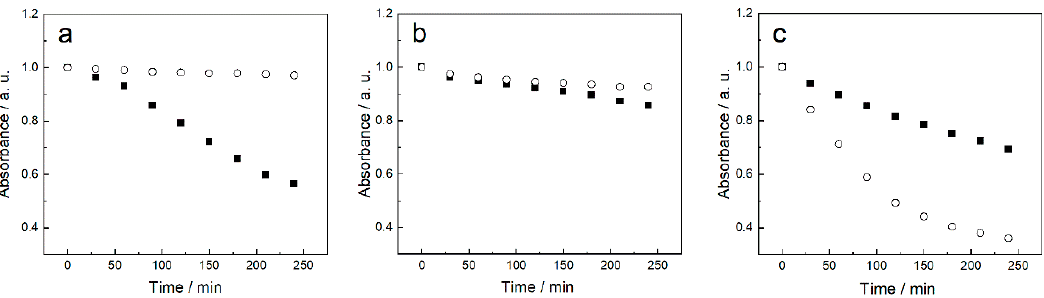
Figure 3. Comparison of time variation of the absorbance at specific wavelengths, referred to its t = 0 value, of quercetin (5 × 10 − 5 M) aqueous solutions in the absence (filled squares) and presence (open circles) of SB3-14 surfactant micelles (2.5 × 10 − 3 M) in double-distilled water at pH 5.5 at 373 nm ( a ), pH 7.0 at 370 nm ( b ), and pH 9.0 at 395 nm ( c ).